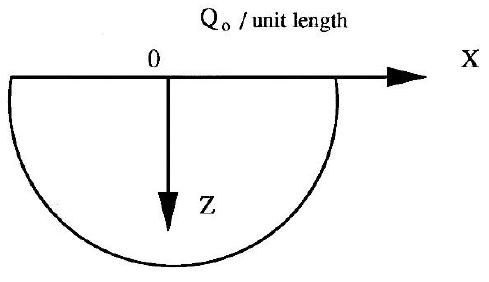
Figure 2. Concentrated electric charge applicable to magneto-piezoelastic medium with free